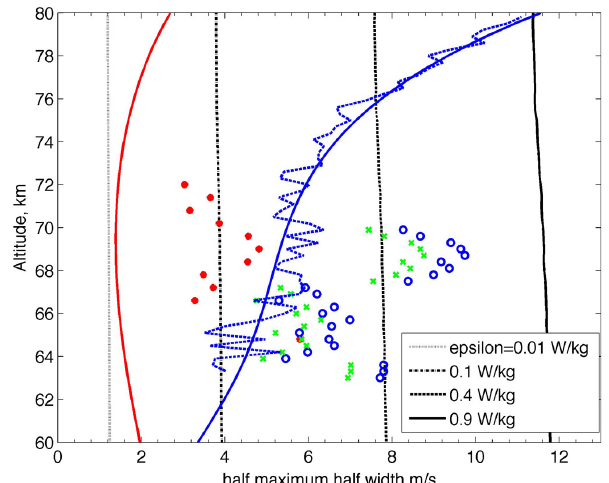
Fig. 9. Profiles of the modelled electron density (left panel) and the ratio of negative ion to electron density (right panel).